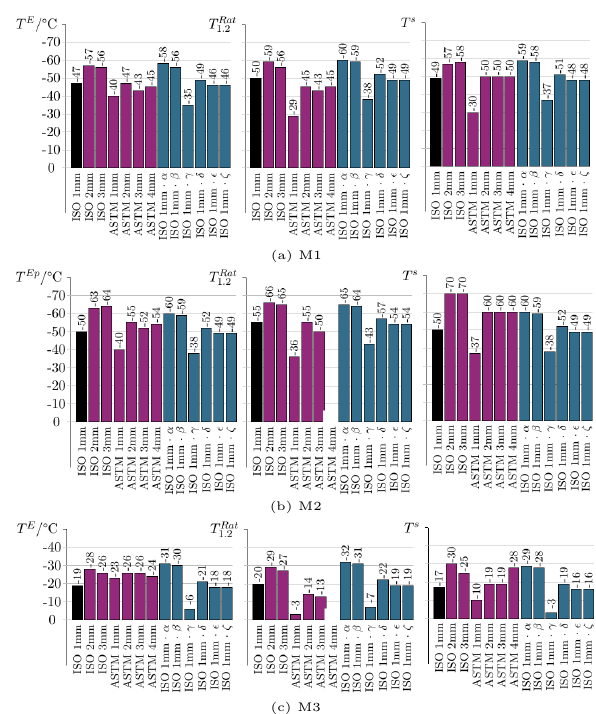
Figure 6. Shift factor predictions versus reality: The trend between ISO 1 mm (black) and thicker specimens (purple) can be predicted (blue) with temperature shift factors α , β , γ , δ , (cid:15) and ζ